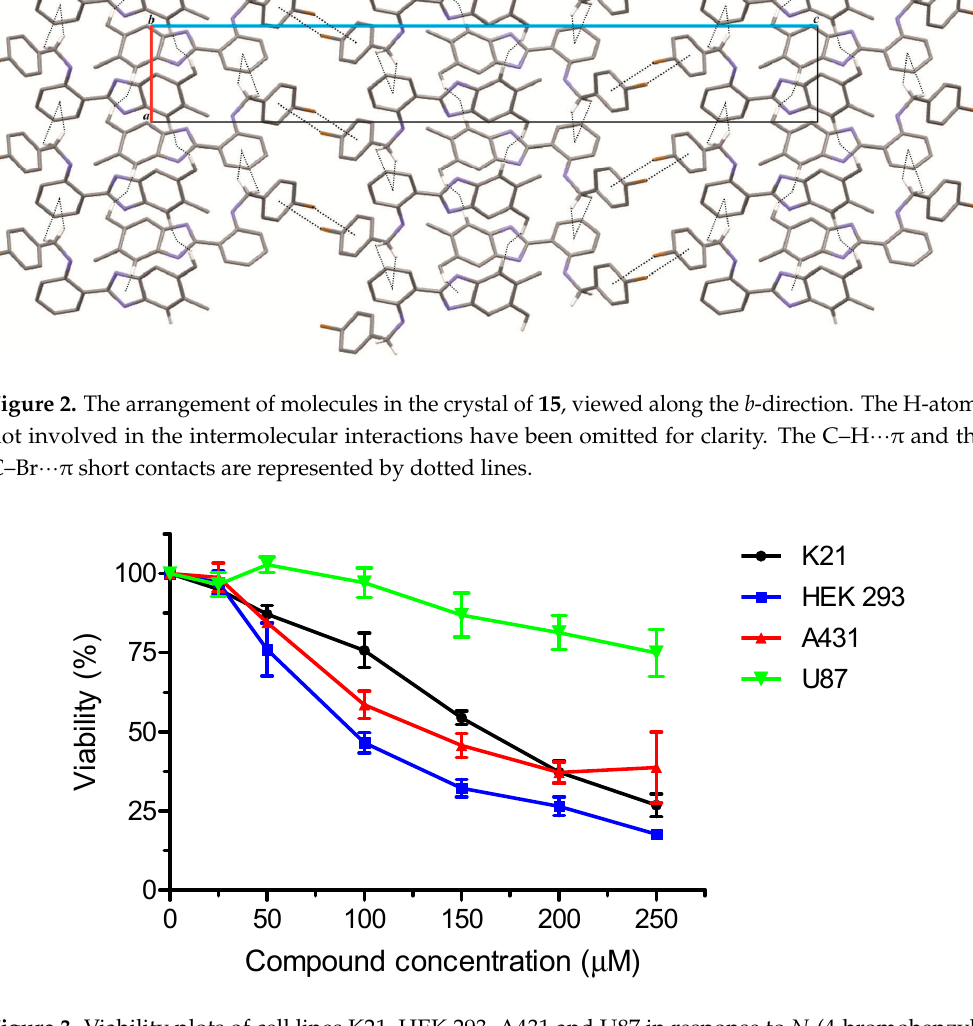
Figure 3. Viability plots of cell lines K21, HEK 293, A431 and U87 in response to N -(4-bromobenzyl)- 2-(5,6-dimethyl-1 H -benzo[ d ]imidazol-2-yl)benzeneamine ( 15 ).